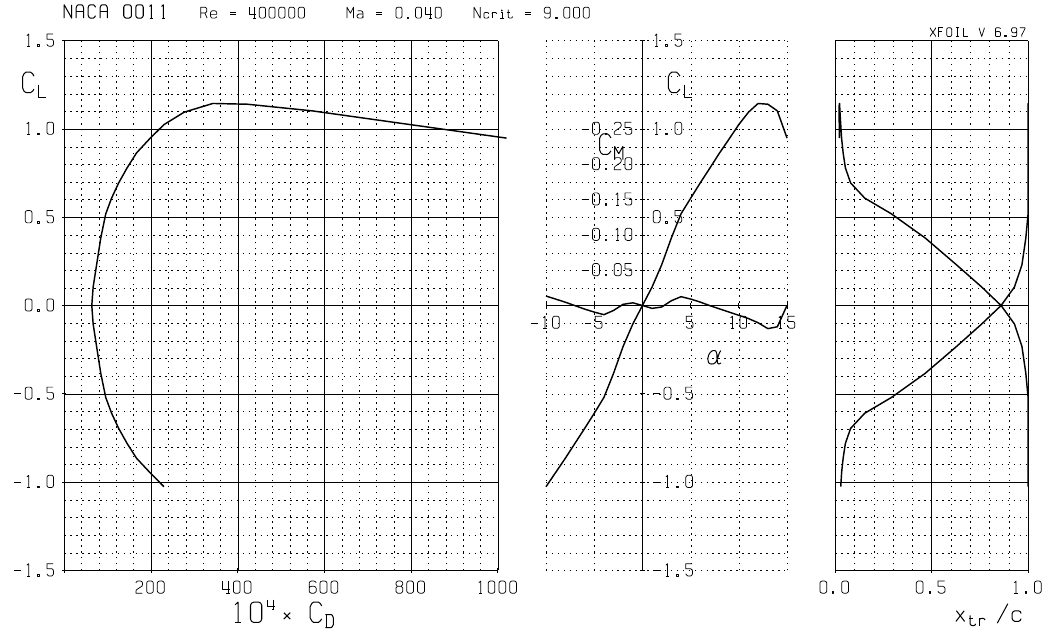
Figure 4. XFOIL aerodynamic properties of NACA0011.